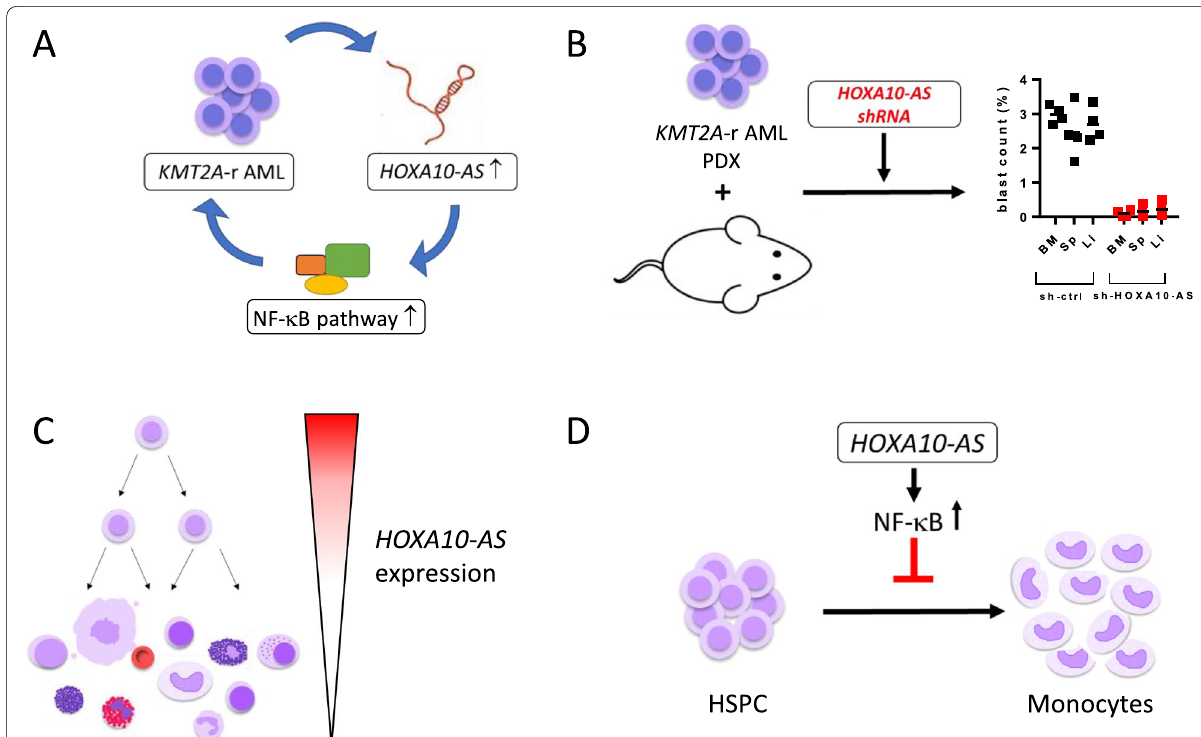
Fig. 1 HOXA10-AS , an example of a lncRNA regulator of hematopoiesis and pediatric leukemia. A HOXA10-AS , is overexpressed in pediatric AML with KMT2A rearrangements, where it increases leukemic proliferation via activation of the NF‑κB signaling pathway. B Knockdown of HOXA10-AS using shRNAs leads to reduced growth of KMT2A ‑r AML patient blasts in vivo. C HOX10-AS is specifically expressed in hematopoietic stem cells and downregulated during hematopoietic differentiation. D Upon overexpression in hematopoietic stem and progenitor cells (HSPCs), HOXA10-AS impairs monocytic differentiation through the activation of NF‑κB target